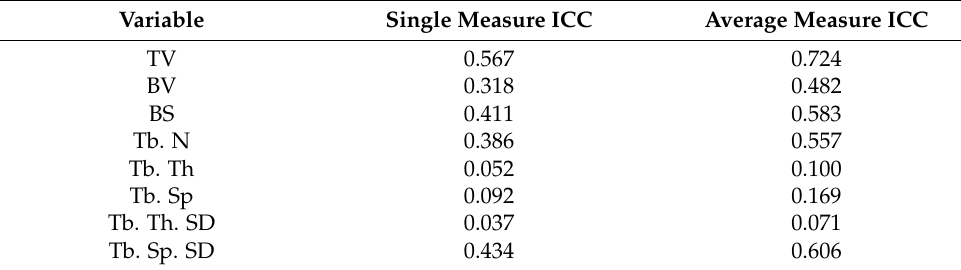
Table 2. The intra-observer